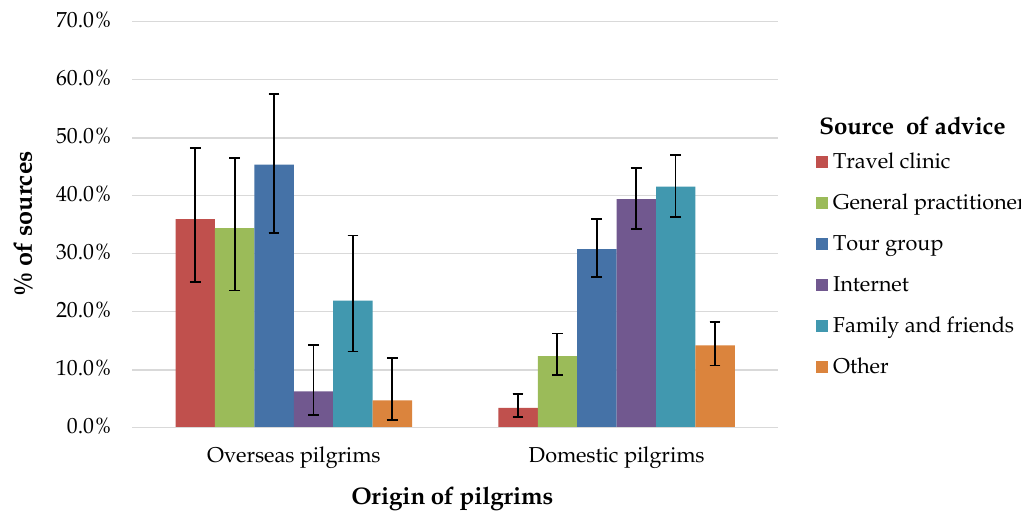
Figure 2. Sources of pre-Hajj health advice among participants who received such advice: proportion of participants providing each response with the 95% confidence interval for the point estimate.